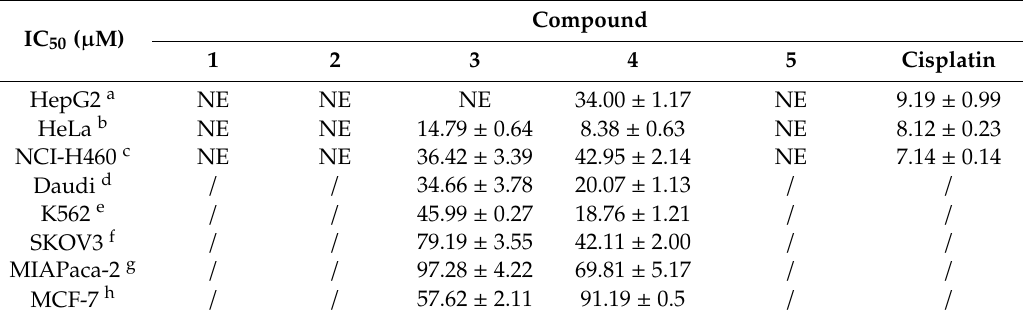
Table 1. Cytotoxic activity of compound 1 – 5 against di ff erent cancer cell lines in vitro. IC 50 ( µ